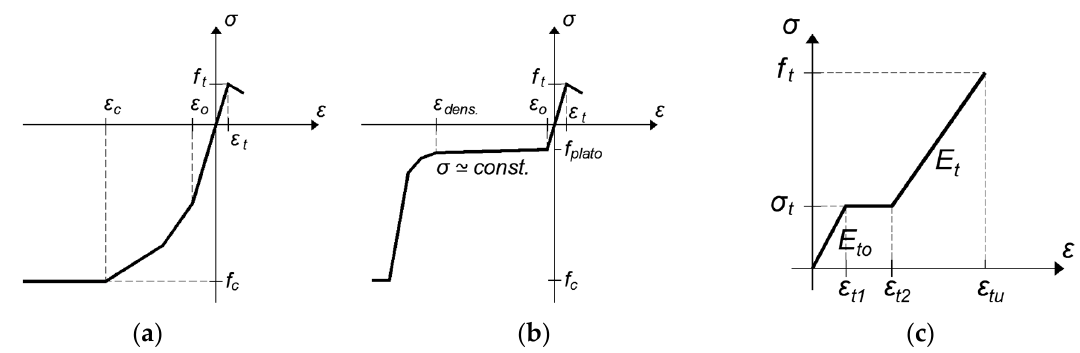
Figure 13. Material models for ( a ) masonry, ( b ) insulation panels, and ( c ) textile-reinforced mortar (TRM).